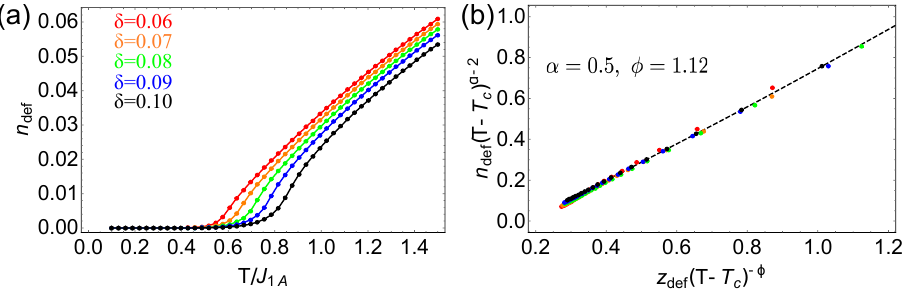
Figure 9: Behaviour of the string density, n [ Eq. 10 ] . For z (cid:54) = 0 the string density remains finite at the critical point, but dn H 1D def a logarithmic divergence (blue).